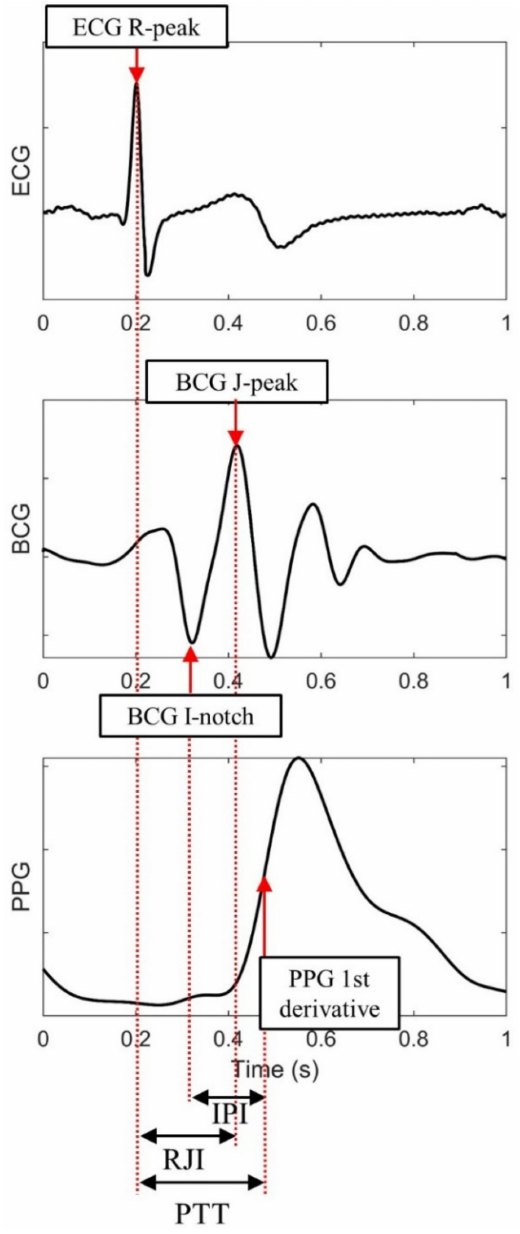
Figure 2. Feature extraction from characteristic points of three signals: electrocardiogram (ECG), ballistocardiogram (BCG), and photoplethysmogram